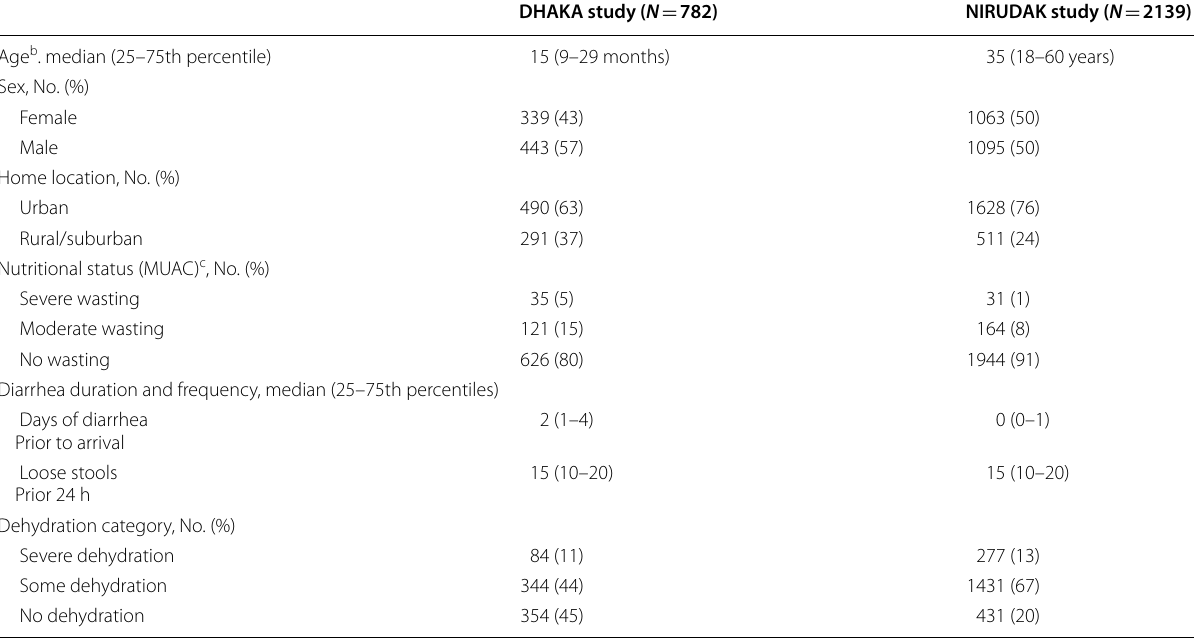
Table 1 Population characteristics